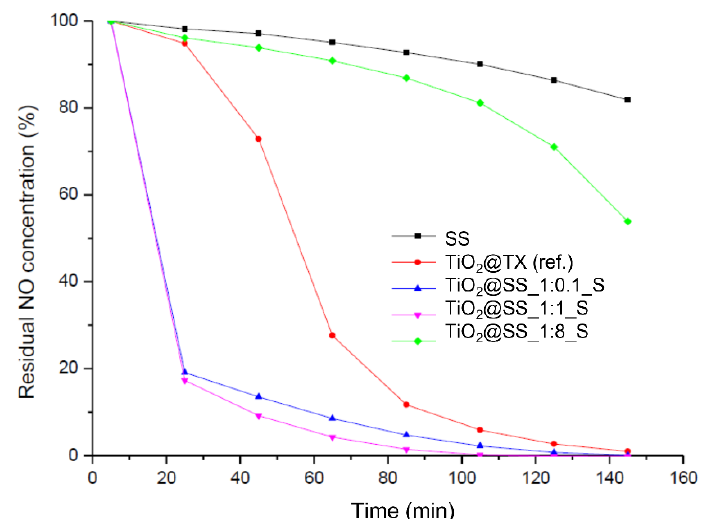
Figure 6. NO depletion trend as a function of UV light time of irradiation .